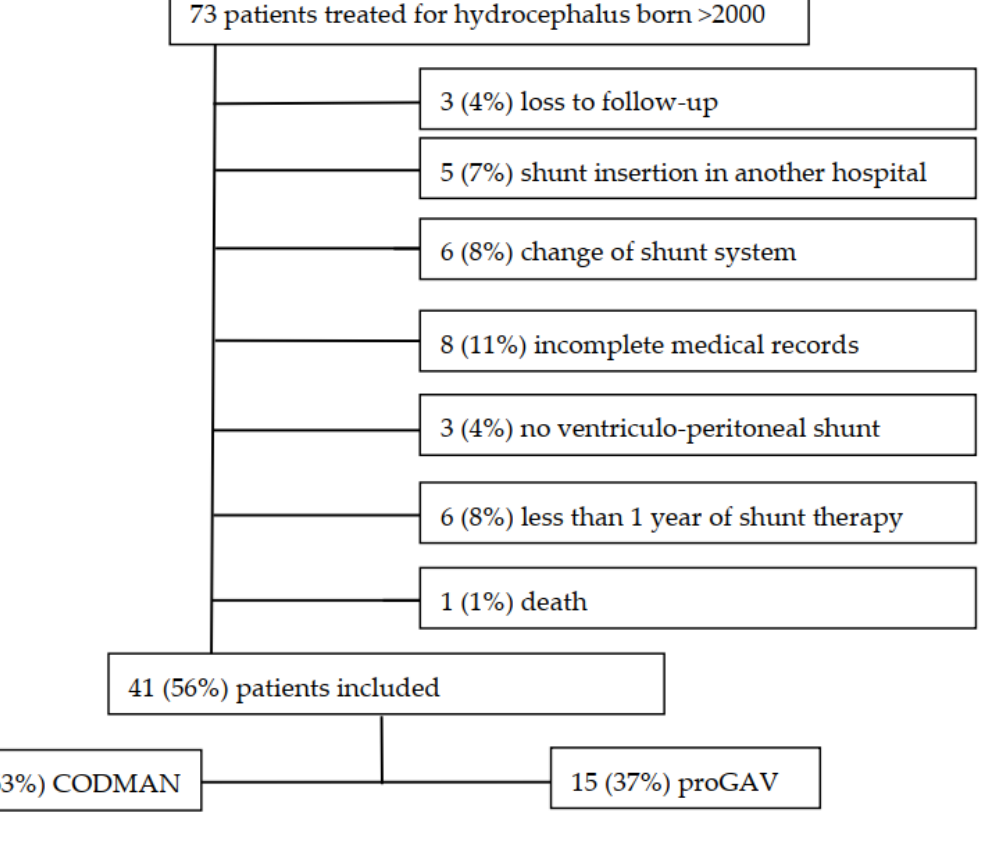
大发发阿的发达 Figure 1. Patient